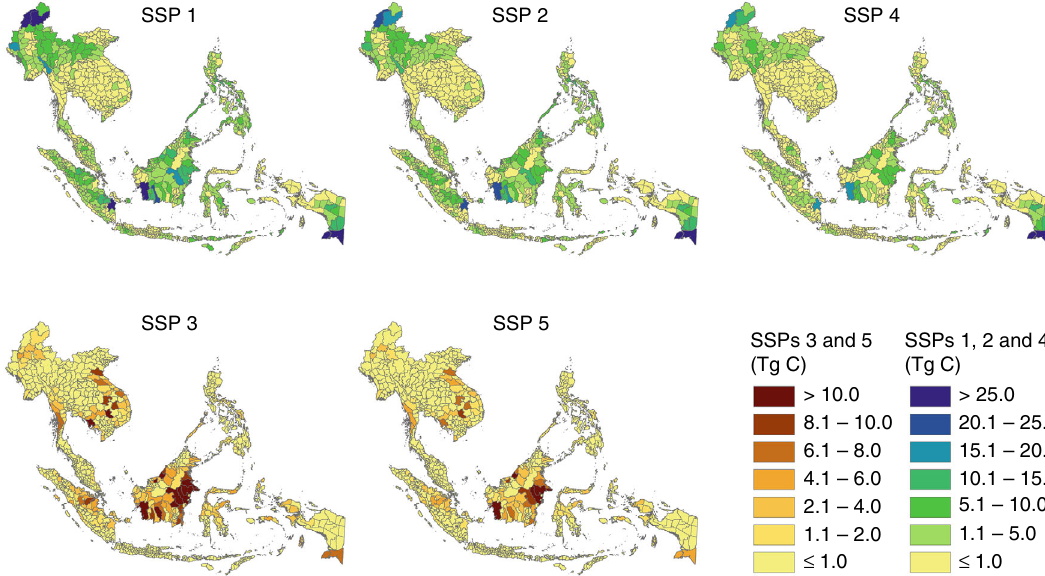
Fig. 3 Province level distribution of the projected aboveground forest carbon stock (AFCS) gains and losses in Southeast Asia (2015 – 2050). Under the worst-case scenario (SSP 3), 17 of the top 30 AFCS-losing provinces were found in Indonesia, while the rest were found in Cambodia (3), Malaysia (3), Myanmar (3), Laos (2) and Vietnam (2). Under the best-case scenario (SSP 1), 17 of the top 30 AFCS-gaining provinces were also found in Indonesia, while the rest were found in Myanmar (7), Malaysia (3), Philippines (1), Laos (1) and Thailand (1). The top 30 provinces under each SSP are given in Supplementary Table 3. Note: Indonesia — regency level; Myanmar and Malaysia — district